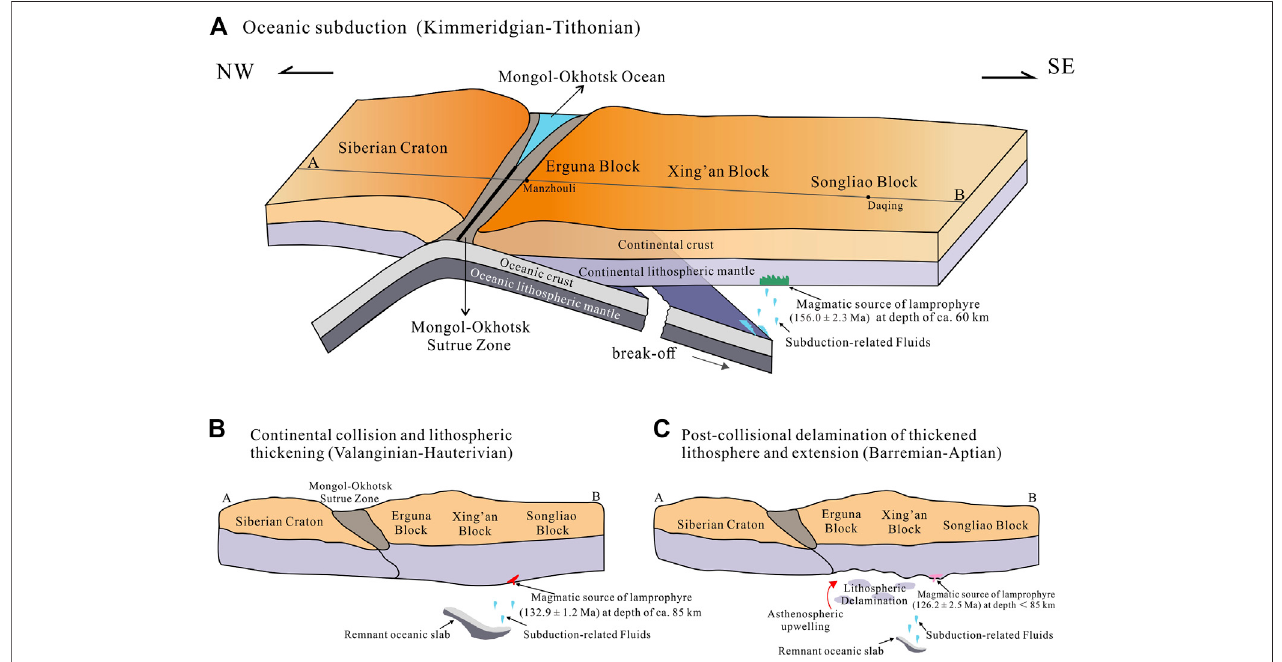
FIGURE13| ThecartoonillustrationsshowingtheLateJurassictotheEarlyCretaceoustectonicevolutionofNEChina. (A) thesoutheastwardsubductionofthe Mongol – Okhotsk oceanic crust that resulted in the suture between the Siberian craton and the Erguna – Xing ’ an – Songliao Blocks in the Kimmeridgian and Tithonian; (B) continental collision of the related Blocks and the following lithospheric thickening near the suture zone in the Valanginian and the Hauterivian; (C) post-collisional delamination of the thickened lithosphere and its extension during the Barremian up to the Aptian.